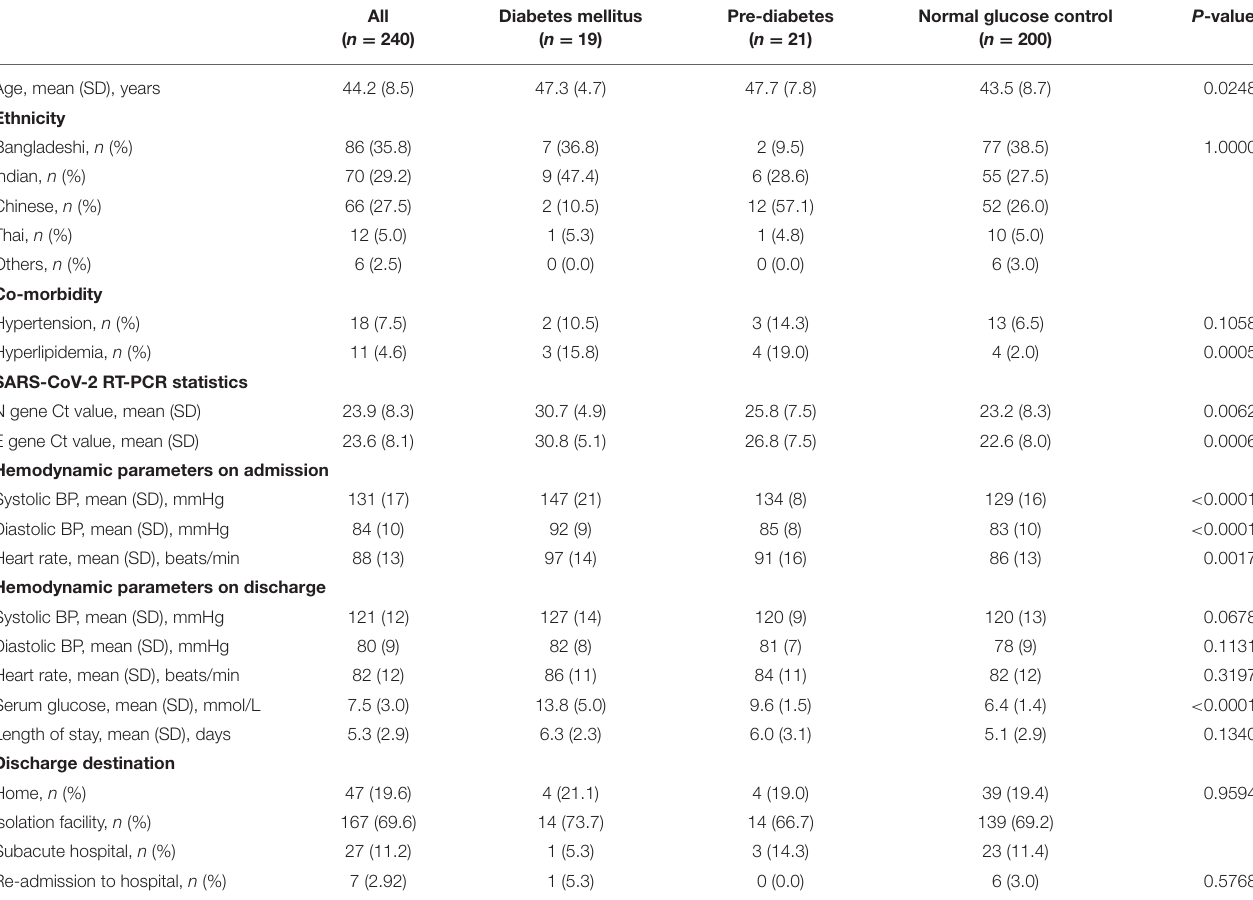
TABLE 2 | Demographics and clinical characteristics, stratified by diagnosis of diabetes mellitus, and pre-diabetes.